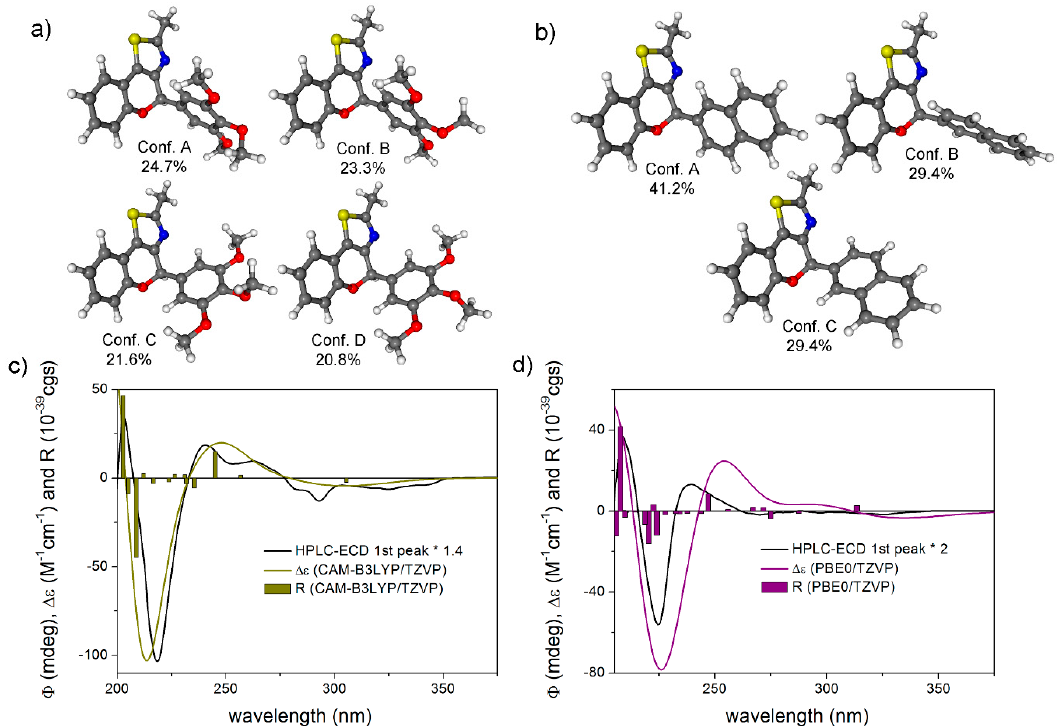
Figure 5. Structures and populations of ( a ) the four lowest energy ω B97X/TZVP PCM/CHCl 3 conformers of ( R )- 3e ( b ) three low-energy ω B97X / TZVP PCM / CHCl 3 conformers of ( R )- 3g . HPLC-ECD spectra of the first-eluting enantiomer (black line) of ( c ) 3e compared with the CAM-B3LYP / TZVP PCM / CHCl 3 // ω B97X / TZVP PCM / CHCl 3 spectrum of ( R )- 3e (olive line), ( d ) 3g compared with the PBE0 / TZVP PCM / CHCl 3 // ω B97X / TZVP PCM / CHCl 3 spectrum of ( R )- 3g (purple line). The bars represent rotational strength values for the lowest energy solution conformers. The terms *1.4 and *2 refer to scaling the intensity of the experimental HPLC-ECD spectra to provide a better fit with the computed curves.